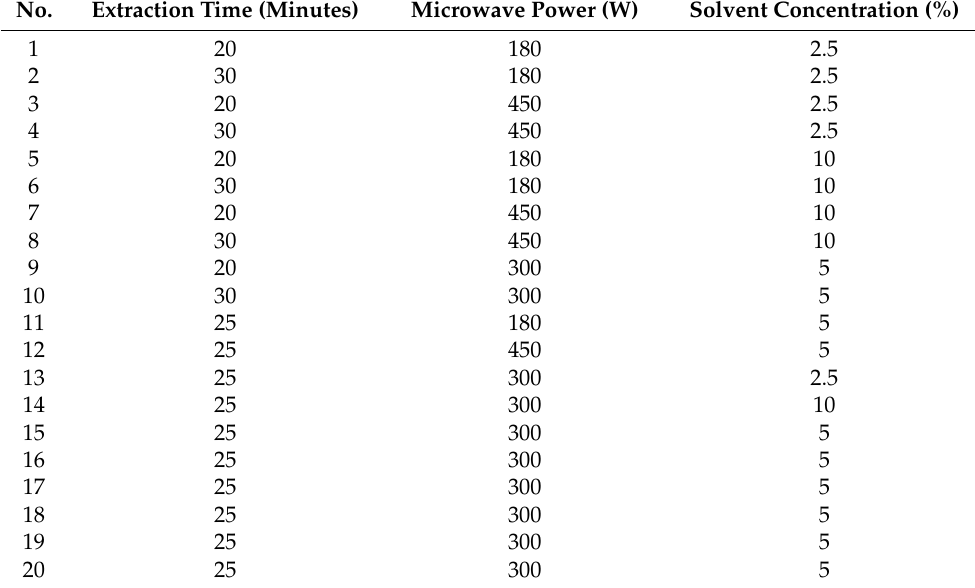
Table 7. Experimental design of pectin